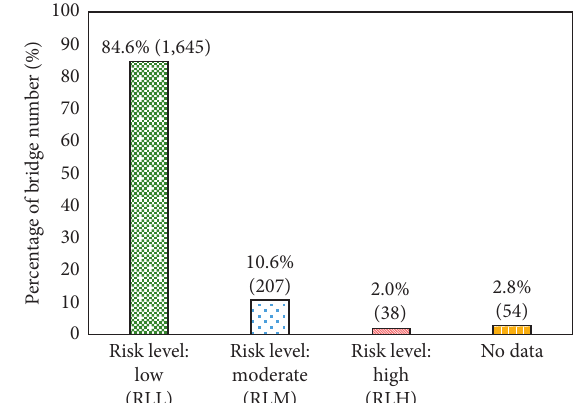
Figure 4: Results of PRA.